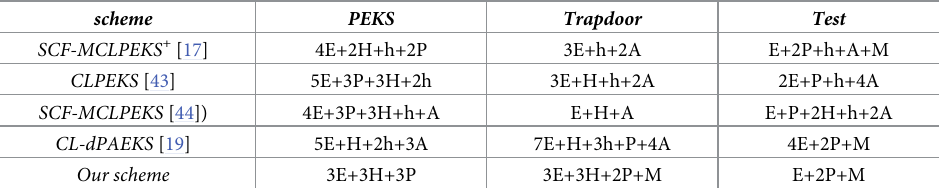
Table 3. Computational efficiency comparison. scheme